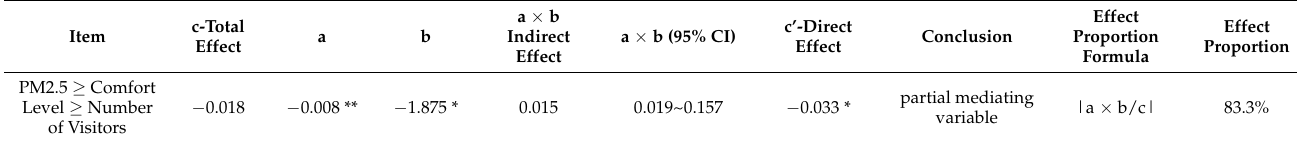
Table 6. Mediating effect testing